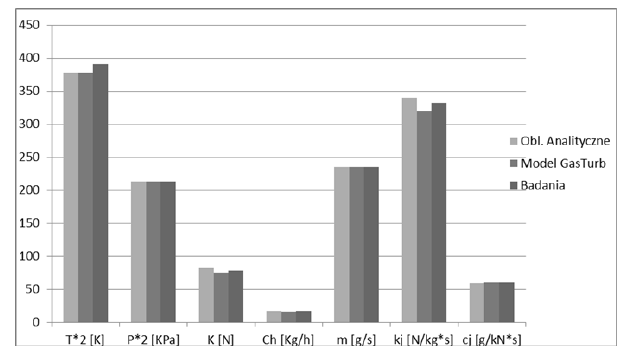
Fig. 8 Comparison of the calculations with the test results